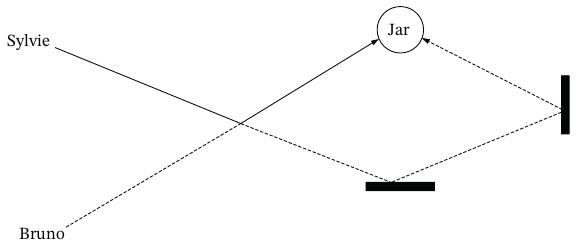
Figure 1: Solid line: actual trajectory of Sylvie’s ball. Dotted line: actual trajec- tory of Bruno’s